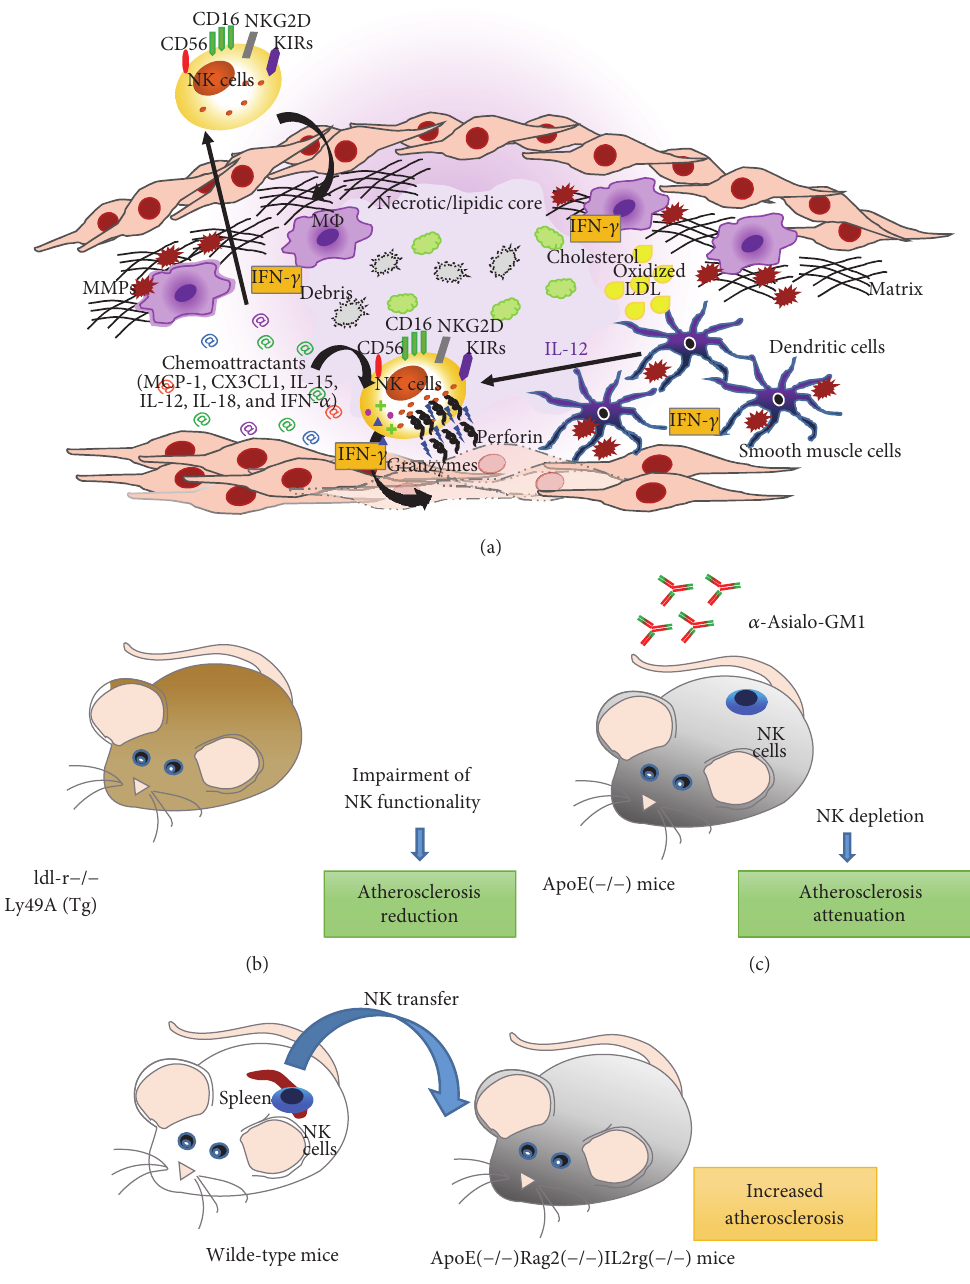
Figure 5: Proatherosclerosis role of natural killer cells. NK ability to induce atherosclerosis has been reported in several murine models and in humans. Several cytokines and chemokines within atherosclerotic lesions are supposed to promote NK recruitment towards atherosclerotic plaque, including monocyte chemoattractant protein-1 (MCP-1), fractalkine (CX3CL1), IL-15, IL-12, IL-18, and IFN- 𝛼 that on one hand enhance NK cell migration and on the other hand induce NK activation resulting in an increased IFN- 𝛾 release. Moreover, these cytokines as far as oxidized LDL also promote the NK crosstalk with other immune cells, that is, dendritic cells and macrophages. DCs activated NKs by releasing IL-12 that in turn induce the production of IFN- 𝛾 by NKs that are able to lyse smooth muscle cells. In addition, IFN- 𝛾 released NK cells that in turn promote metalloproteinases (MMPs) secretion from cDCs and M Φ (a). In a chimeric atherosclerosis-susceptible low-density lipoprotein (LDL) receptor null (ldl-r − / − ) mouse model, characterized by the impairment of NK cell functionality through the expression of a transgene encoding for Ly49A, it has been demonstrated that even if no difference in either serum total cholesterol concentrations or lipoprotein cholesterol distribution was observed between the two groups of mice, in Ly49A transgenic group, the deficiency of functional NK cells significantly reduced the size of atherosclerosis by 70% in cross-sectional analysis of the aortic root and by 38% in the intimal surface of the aortic arch (b). The administration of anti-Asialo-GM1 antibodies in ApoE( − / − ) mice induces a NK cells depletion leading to an attenuation of atherosclerosis (c). The transfer of NK cells isolated from murine spleen into ApoE( − / − )Rag2( − / − )IL2rg( − / − ) induces an enhancement of atherosclerosis